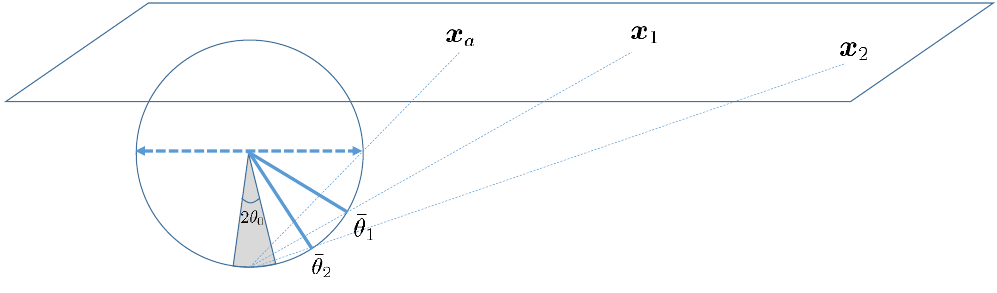
Figure 7 . The stereographic projection in the COM frame of the di-jets and for an exclusion region making a small angle (cid:18) 0 around the negative z axis. The successive, soft, gluon emissions make smaller and smaller angles w.r.t. the negative z axis, (cid:18) 0 (cid:28) (cid:22) (cid:18) 2 (cid:28) (cid:22) (cid:18) 1 . They are projected onto points with increasing transverse coordinates in the tangent plane: j x a (cid:0) x b j (cid:28) j x 1 j (cid:28) j x 2 j . The projection relates the collinear time-like evolution to the anti-collinear space-like